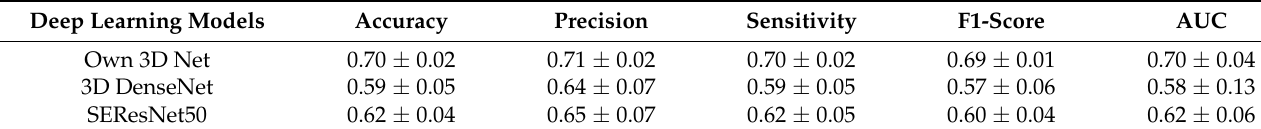
Table 3. The outcome of the deep learning models.